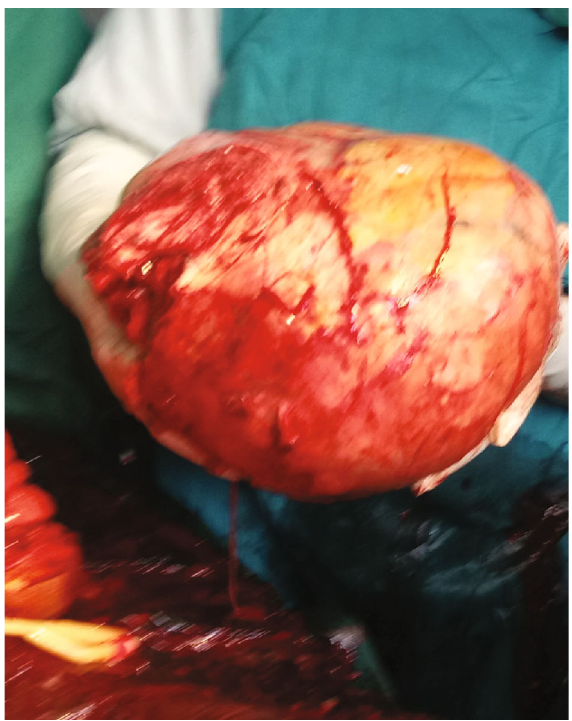
Figure 3: Removed fi broid